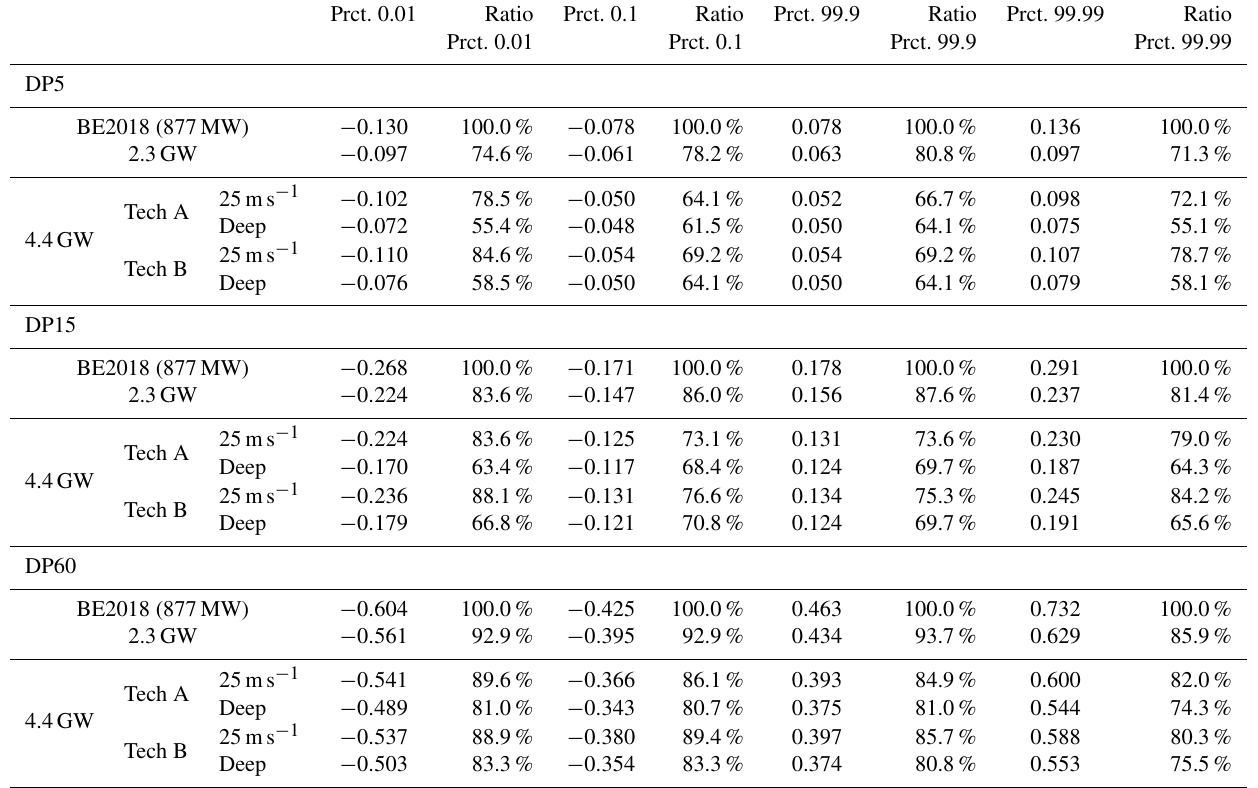
Table 5. Extreme power ramps in 5, 15, and 60min and their relative ratios with respect to BE2018. Prct.